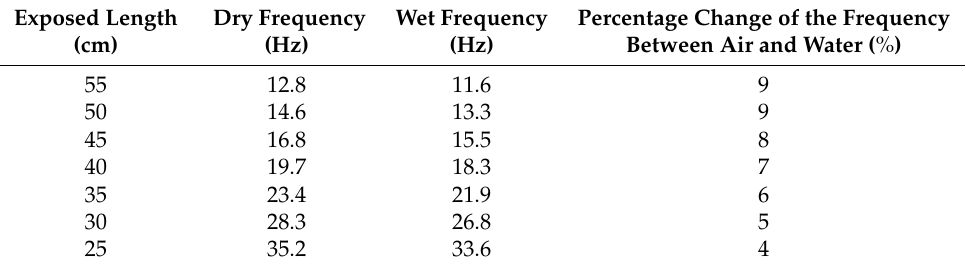
(cid:115) 1 3 EI × 2 π H c 3 ( 0.24 M + m )